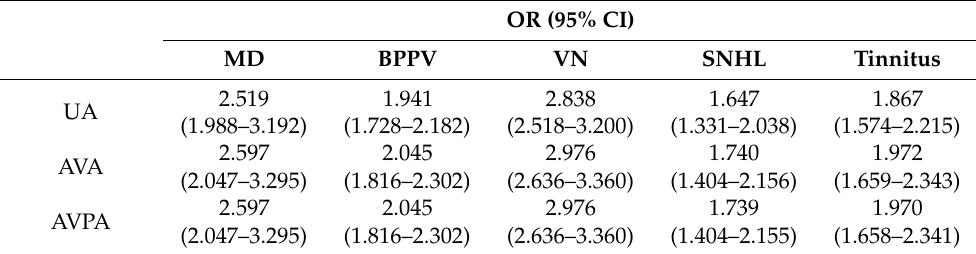
Table 3. ORs for vestibular and cochlear disorders in migraine patients after